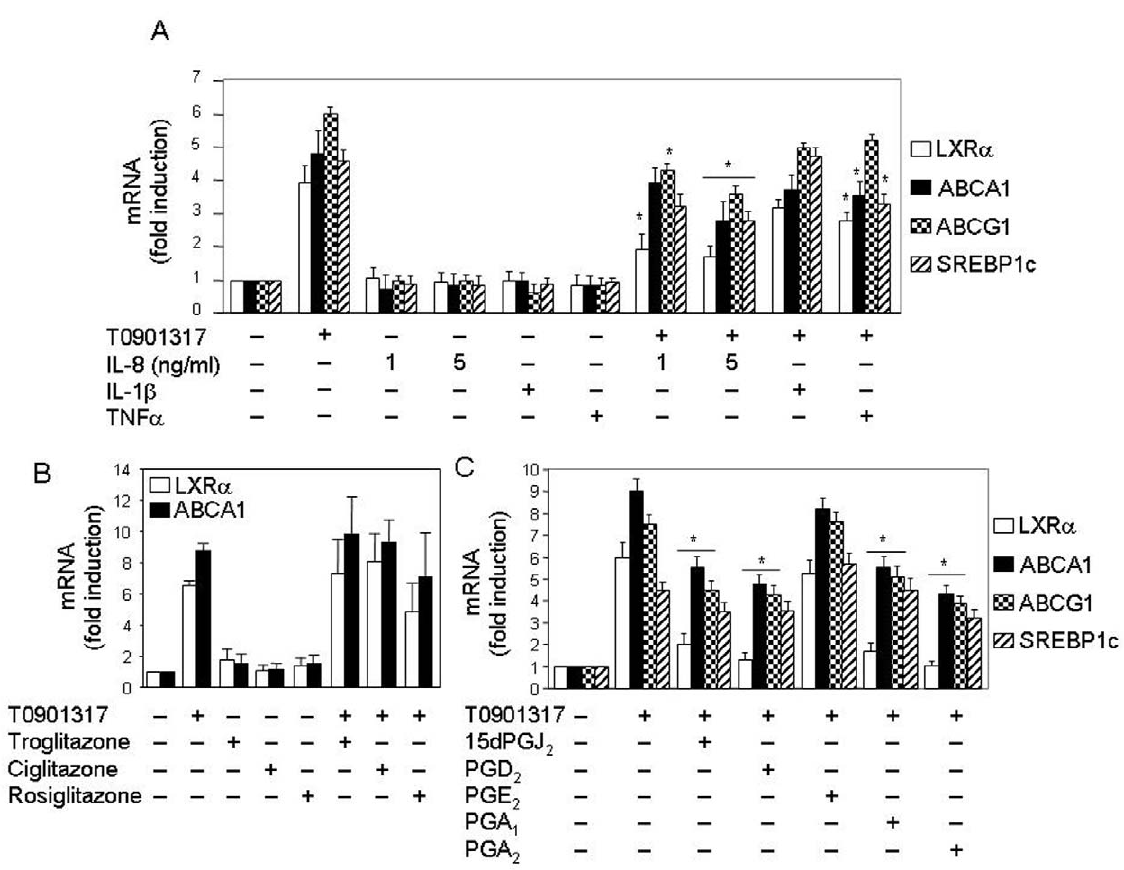
Figure 3. Pro-inflammatory cytokines and prostaglandins, but not PPAR agonist, inhibit induction of mRNA expression of LXR a target genes in human neutrophils. Neutrophils were preincubated at 37 u C for 1 h with or without 330 ng/ml IL-1 b , 200 ng/ml TNF a or IL-8 at the indicated doses (A), 1 m M troglitazone, 1 m M ciglitazone or 1 m M rosiglitazone (B),or else with 10 m M 15dPGJ 2 , 10 m M PGD 2 , 10 m M PGE 2 , 15 m M PGA 1 or 25 m M PGA 2 (C). Then, after incubation in the absence or presence of 1 m M T0901317 for 18 h, the levels of LXR a , ABCA1, ABCG1 and SREBP1c mRNAs were analyzed by real time RT-PCR. Statistical data (mean 6 SEM, n=3) were corrected for differences in b -actin mRNA levels and expressed as fold induction. * P , 0.01 for treated with pro-inflammatory cytokines (A) or prostaglandins (C) plus T0901317-stimulated versus untreated, T0901317-stimulated